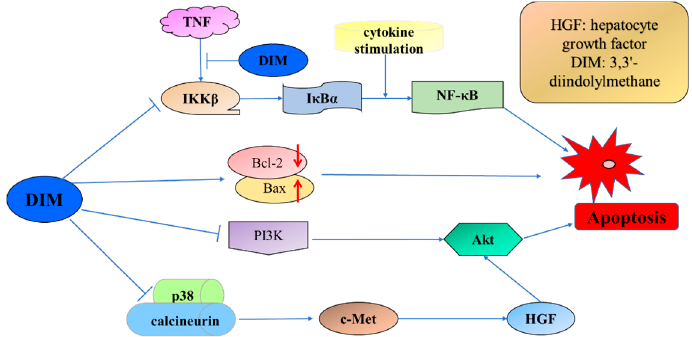
Figure 3. Signaling pathways involved in DIM-induced apoptosis in breast cancer cells.